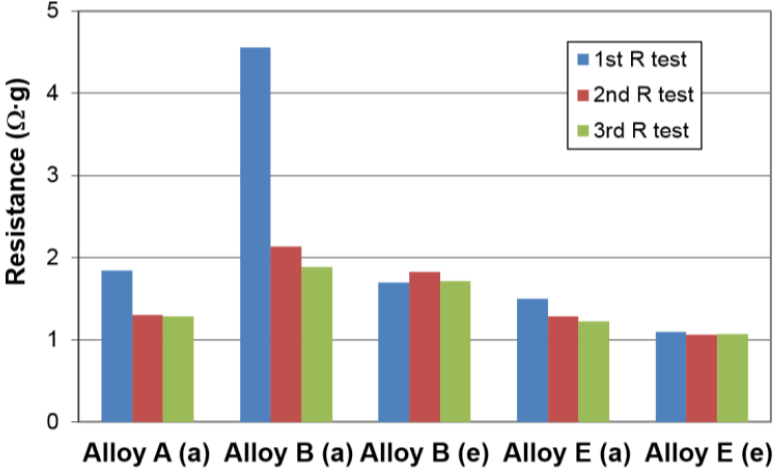
Figure 4. Examples of three internal resistance results from A (as-is only), B (both as-is and etched), and E (both as-is and etched). (a) and (e) in parentheses represent for as-is and Table 2. Electrochemical discharge capacity measured at 50 mA·g ‒1 , surface charge-transfer resistance ( R ) from AC impedance measurement, and specific power density.